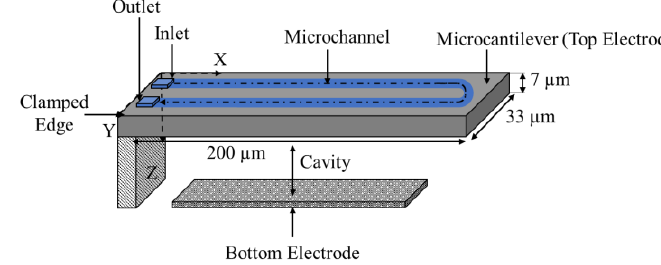
Figure 8. Schematic view of a microchannel microcantilever structure (image not to